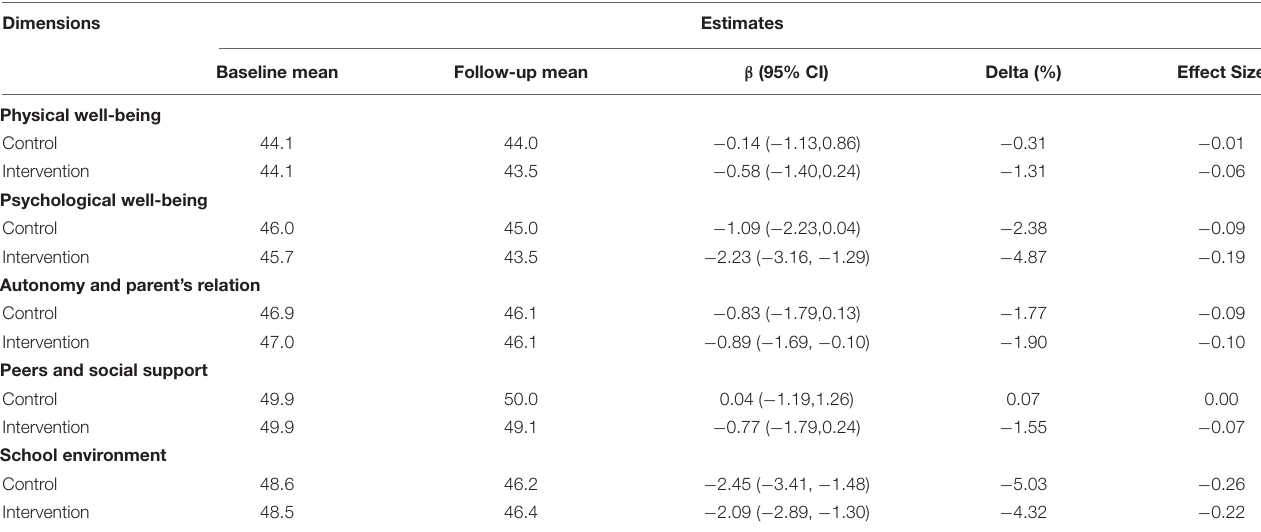
TABLE 2 | Effects of the Movimente Program on dimensions of HRQoL among total sample.